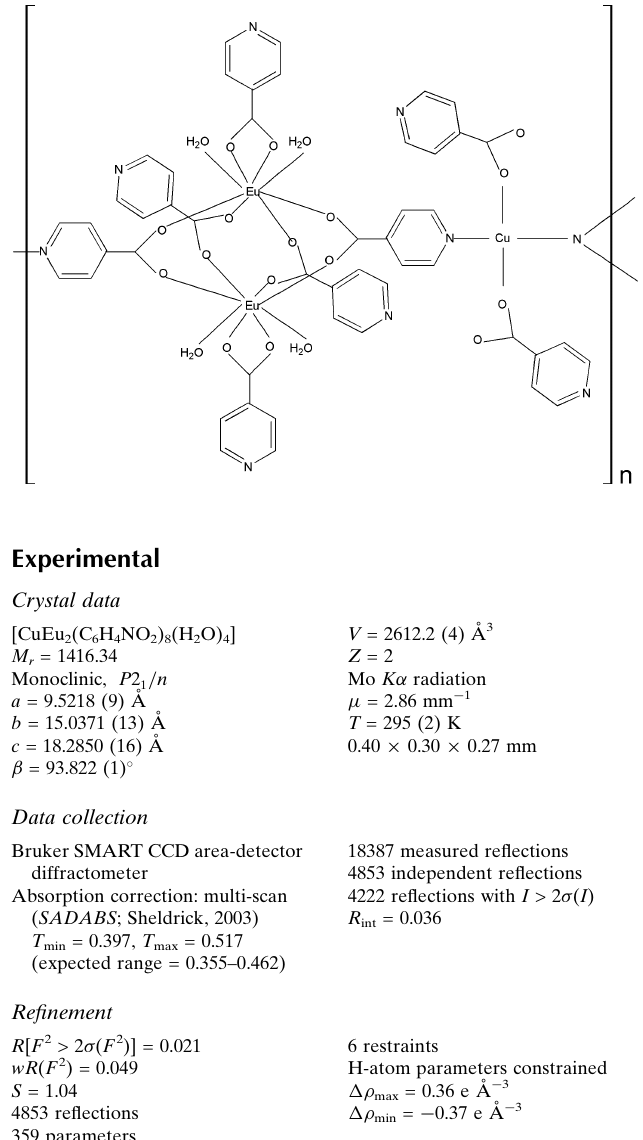
Related literature